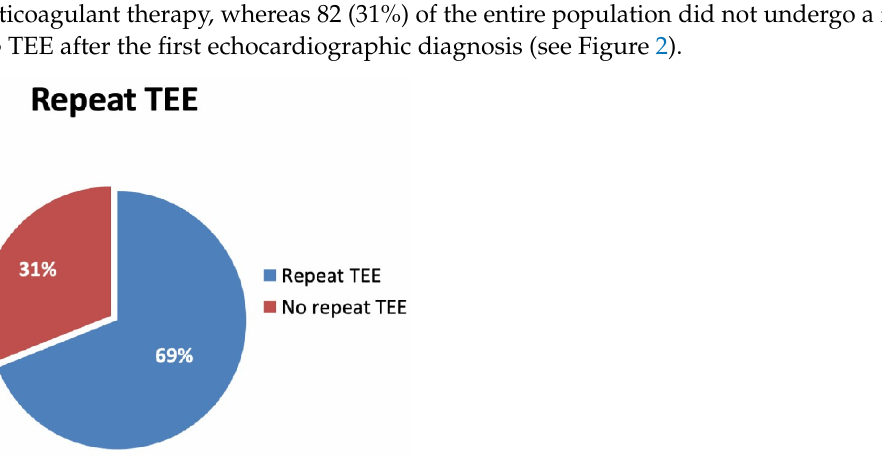
Table 3. Anticoagulant therapy after diagnosis of LAA thrombus . VKA, vitamin K s; NOAC, non- vitamin K antagonist oral anticoagulants.